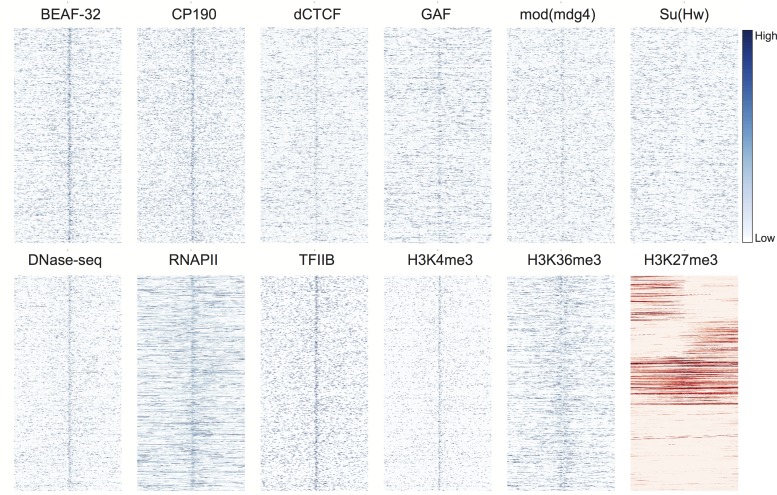
Genomic signals around H3K4me1 peaks.Data were prepared and displayed identically to Figure 3 for the top 1000 peaks of H3K4me1 in stage 5 5 embryos, as identified by (Li et al., 2014). H3K4me1 is a proxy for active enhancers.